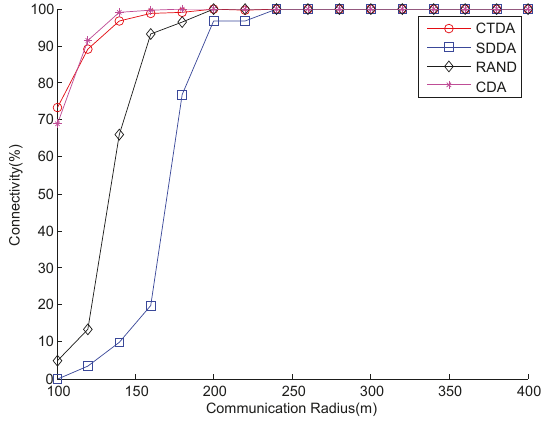
Figure 10. Connectivity with varying communication radii under a sparse